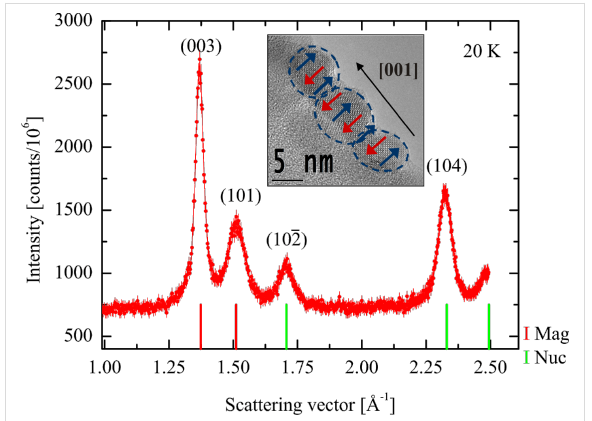
Figure 4: Neutron diffraction data for interacting 8 nm α -Fe 2 O 3 particles obtained at 20 K. The inset shows a TEM image of three α -Fe 2 O 3 particles attached along their common [001] axis. The antifer- romagnetic order is indicated by the blue and red arrows superim- posed on the TEM image. Adapted from Frandsen, C.; Bahl, C. R. H.; Lebech, B.; Lefmann, K.; Kuhn, L. T.; Keller, L.; Andersen, N. H.; von Zimmermann, M.; Johnson, E.; Klausen, S. N.; Mørup, S. Oriented attachment and exchange coupling of α -Fe 2 O 3 nanoparticles, Phys. Rev. B 2005, 72, 214406. Copyright (2005) by the American Physical